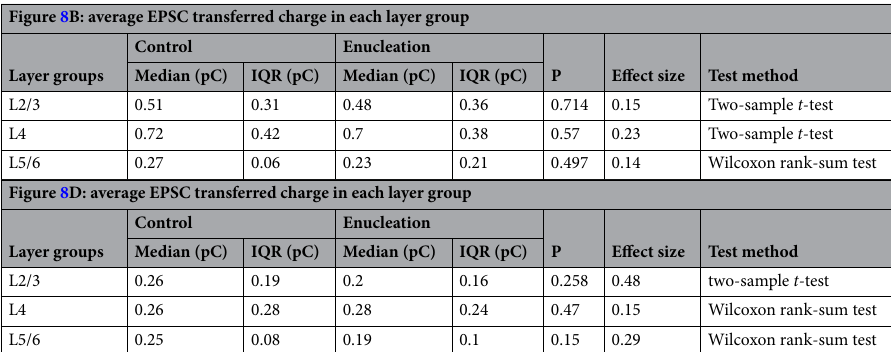
Figure 8D: average EPSC transferred charge in each layer group Layer